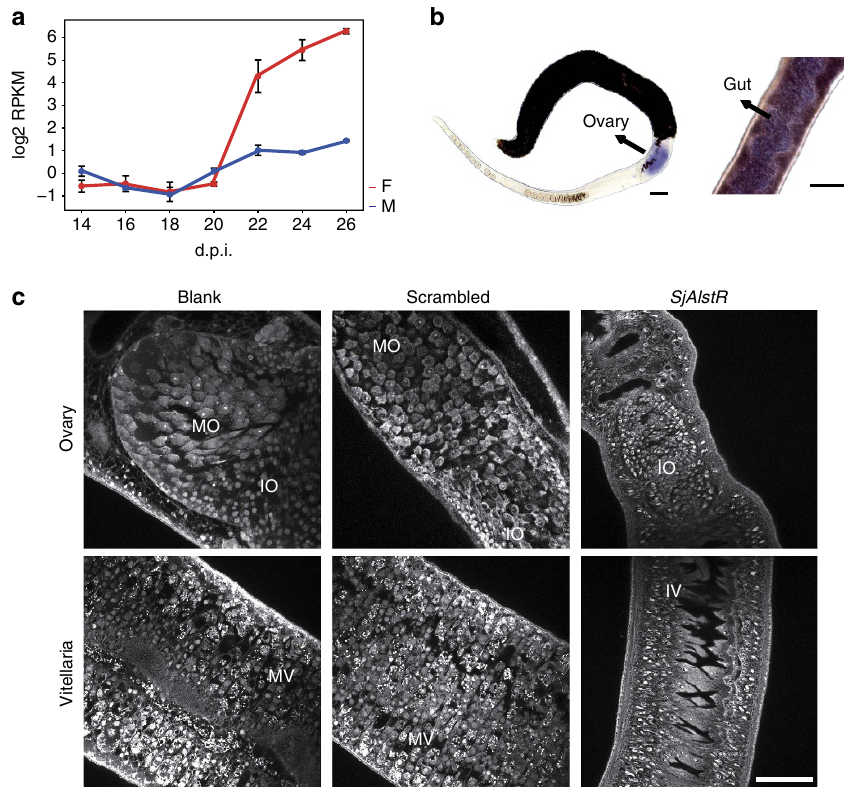
Figure 5 | Expression and function of allatostatin-A receptor-like gene in S. japonicum (SjAlstR). ( a ) The expression pattern of Fcomp1627_c0_seq1 in both sexes at 14–26d.p.i. Red, female; blue, male (mean ± s.e.m., n ¼ 3). ( b ) Whole-mount in situ hybridization of the SjAlstR gene in the female worm. n 4 3 parasites. Purplish blue regions indicate presence of the gene product. Scale bars, 100 m m. ( c ) Morphological changes in the female reproductive system after in vivo RNAi with blank, scrambled and SjAlstR shRNA plasmid. IO, immature oocyte; IV, immature vitelline cell; MO, mature oocyte; MV, mature vitelline cell. n 4 5 per experiment. Scale bar, 50 m